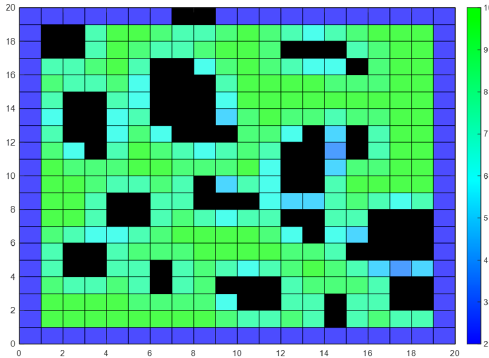
Figure 2. The case of our initial pheromone distribution.